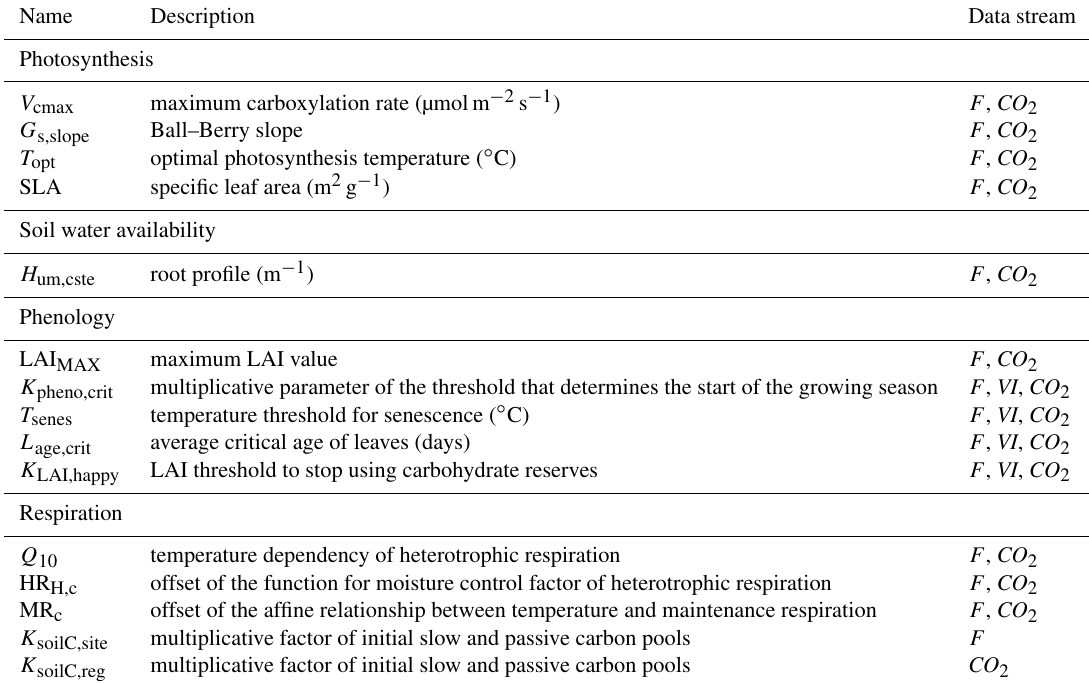
Table 1. List of the ORCHIDEE parameters to be optimized and data streams that constrain them ( F for in situ flux measurements, VI for normalized satellite NDVI data and CO 2 for atmospheric CO 2 concentration data).